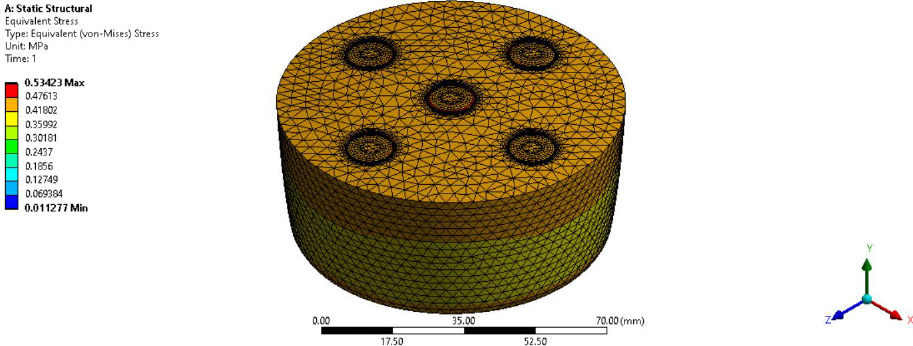
Figure 16. State of stress for 5 large straws (under a load of 2000 N).